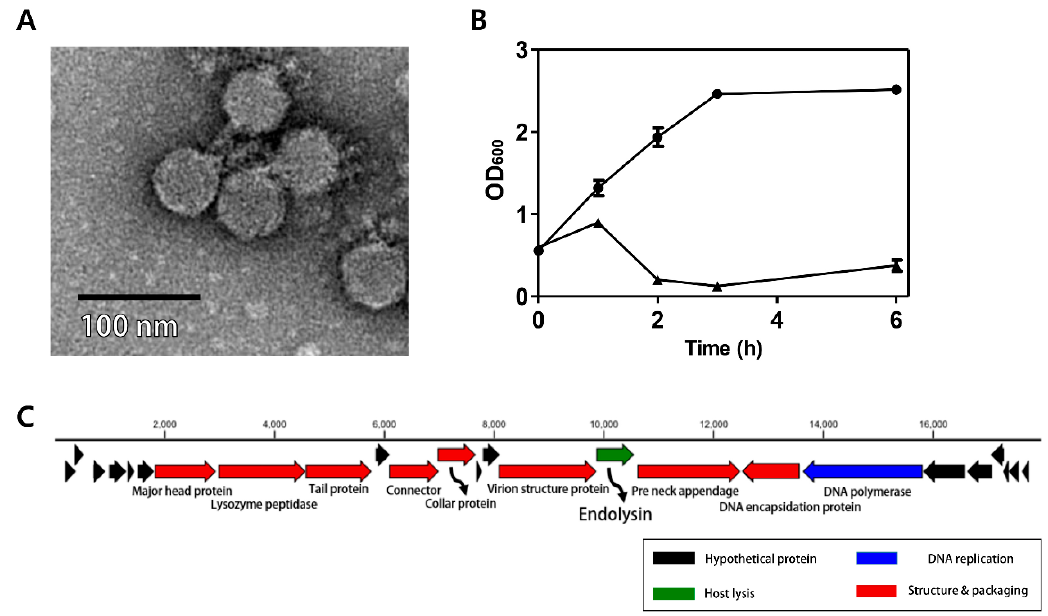
Figure 1. Characterization of C. perfringens virulent phage CPS2. ( A ) TEM image of CPS2; ( B ) bacterial challenge assay of CPS2 against C. perfringens ATCC 13124. The closed circle indicates non-phage-treated C. perfringens ATCC 13124, and the closed triangle indicates phage-treated C. perfringens ATCC 13124; ( C ) genome map of CPS2. Red: structure and packaging, blue: DNA replication, green: host lysis, black: hypothetical protein. Twenty-five putative ORFs were predicted in the CPS2 genome.